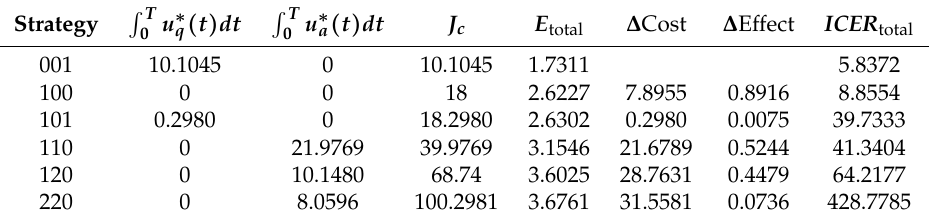
Table 8. ICER calculation for the remaining strategies with respect to their combined effects E total